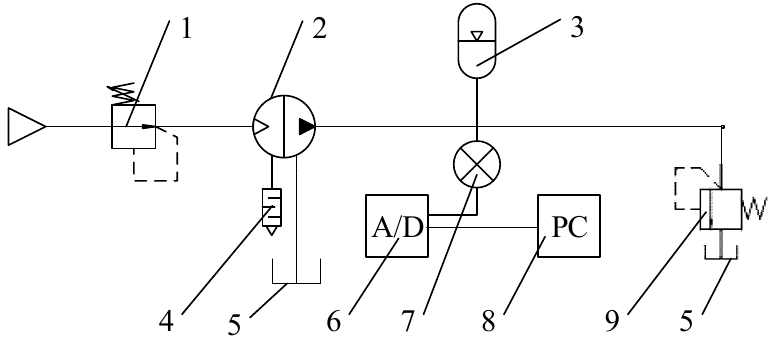
Figure 3. Schematic structure of the HP transformer: (1) Regulator; (2) HP transformer; (3) Accumulator; (4) Silencer; (5) Tank; (6) Data acquisition card; (7) Pressure sensor; (8) Computer; (9) Relief valve.